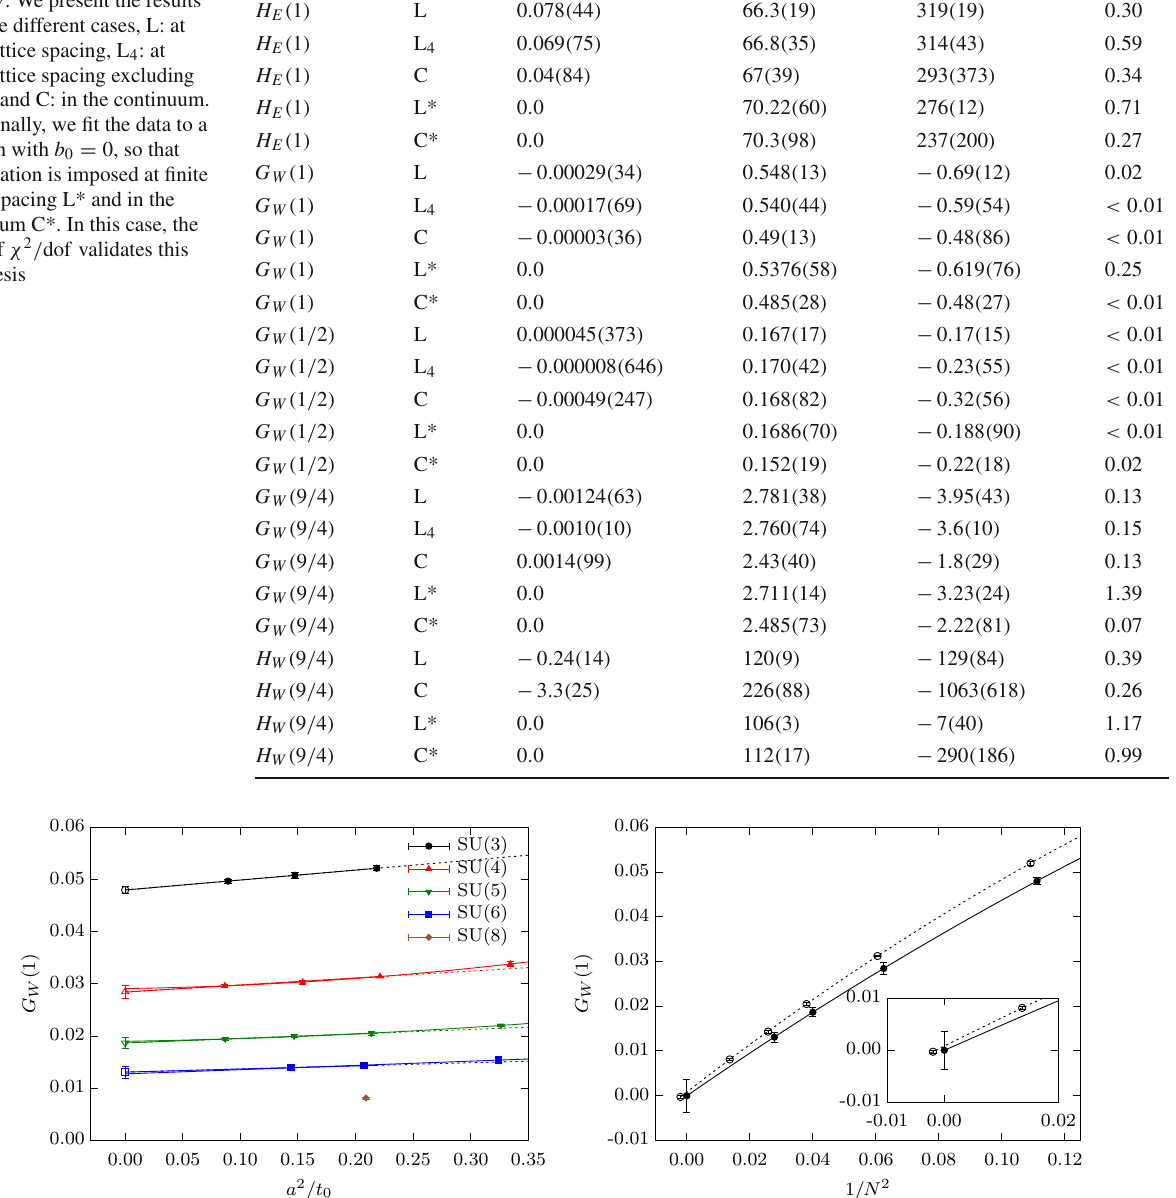
Table 3 Parameters of the large N extrapolations of H E , G W